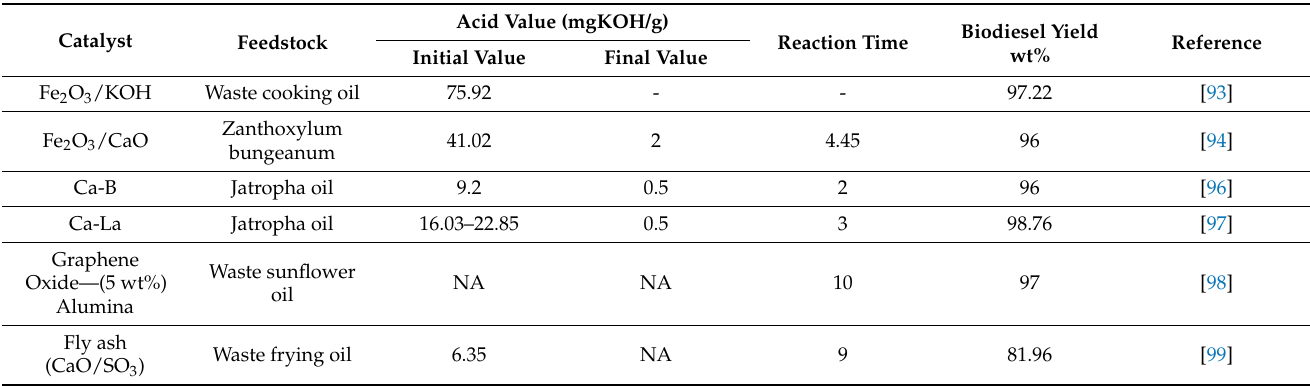
Table 3. Some novel heterogeneous solid acid catalysts for the production of biodiesel from the low-quality feedstocks.